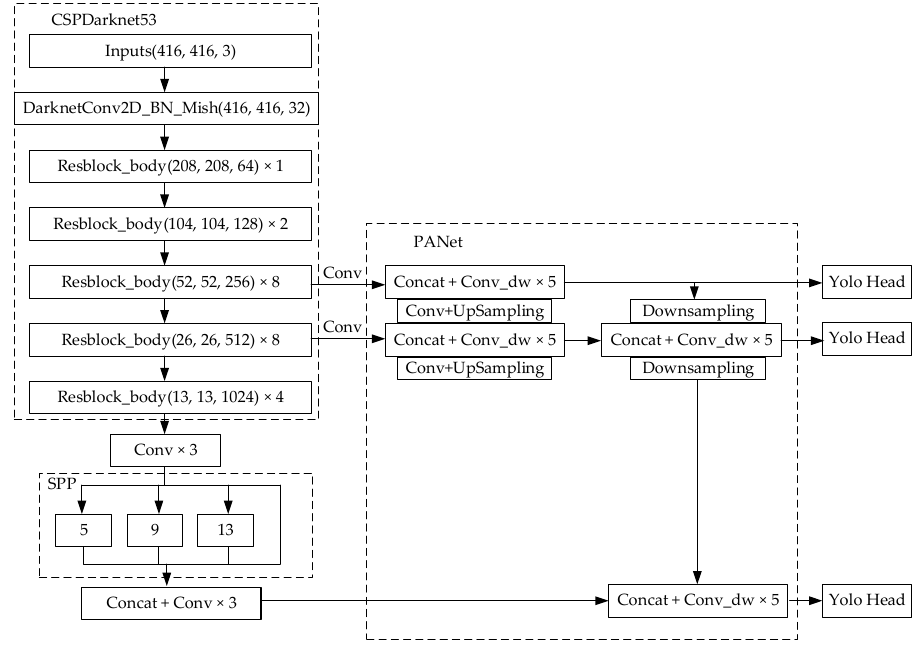
Figure 3. YOLOv4 model structure. Among them, the backbone feature extraction network is CSPDarknet53, which con- sists of multiple residual blocks. When the feature image is input into the YOLOv4 net- work, the YOLOv4 network first adjusts the size of the feature image to 416 × 416, and then it segments the adjusted feature image into 13 × 13, 26 × 26, and 52 × 52; that is, the function of the CSPDarknet53 feature extraction network is to obtain 52 × 52, 26 × 26, and 13 × 13, three effective characteristic layers. The enhanced feature extraction network mainly includes the Spatial Pyramid Pooling (SPP) structure and the Path Aggregation Network (PANet) [26]. The SPP module performs 5 × 5, 9 × 9, and 13 × 13 maximum pool- ing of the three scales; then, the tensor concat is fused into a feature map, and the dimen- sion reduction through convolution separates important context feature information on the premise of ensuring speed. The PANet includes up-sampling and down-sampling op- erations. By fusing top-down semantic features and bottom-up strong positioning fea- tures, the loss of target shallow feature information is alleviated, and the representation ability of the model is increased. The head prediction network, namely, the Yolo Head module, is the output layer of the YOLOv4 network [27]. The three heads correspond to